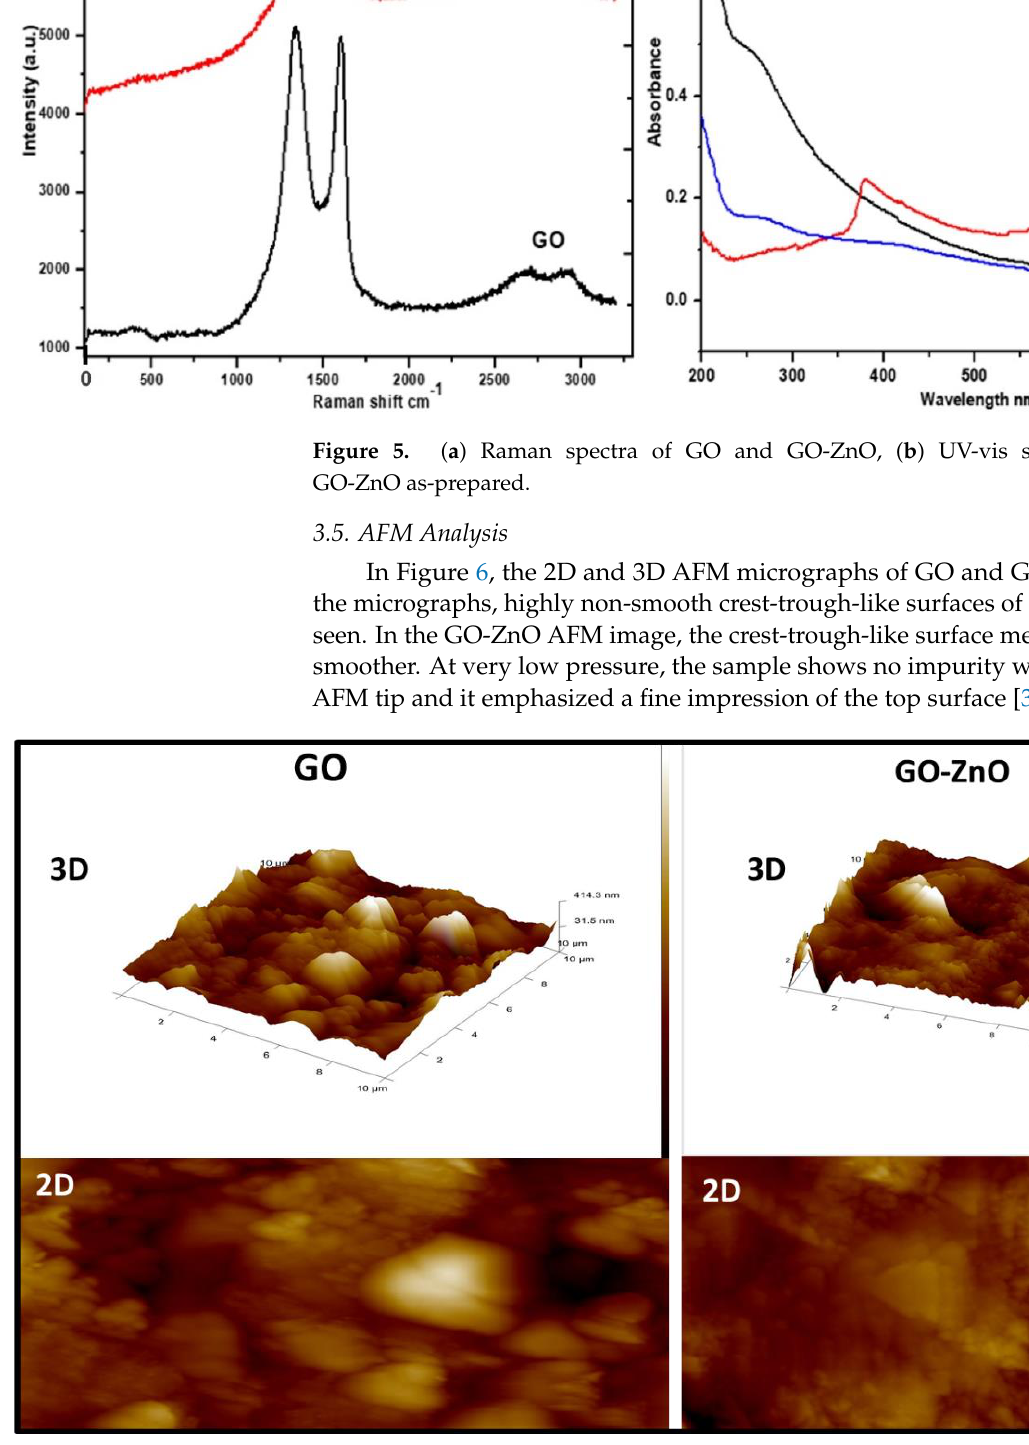
Figure 6. Atomic force microscopy images of the as-prepared composite of GO and GO-ZnO in 3D and 2D format.